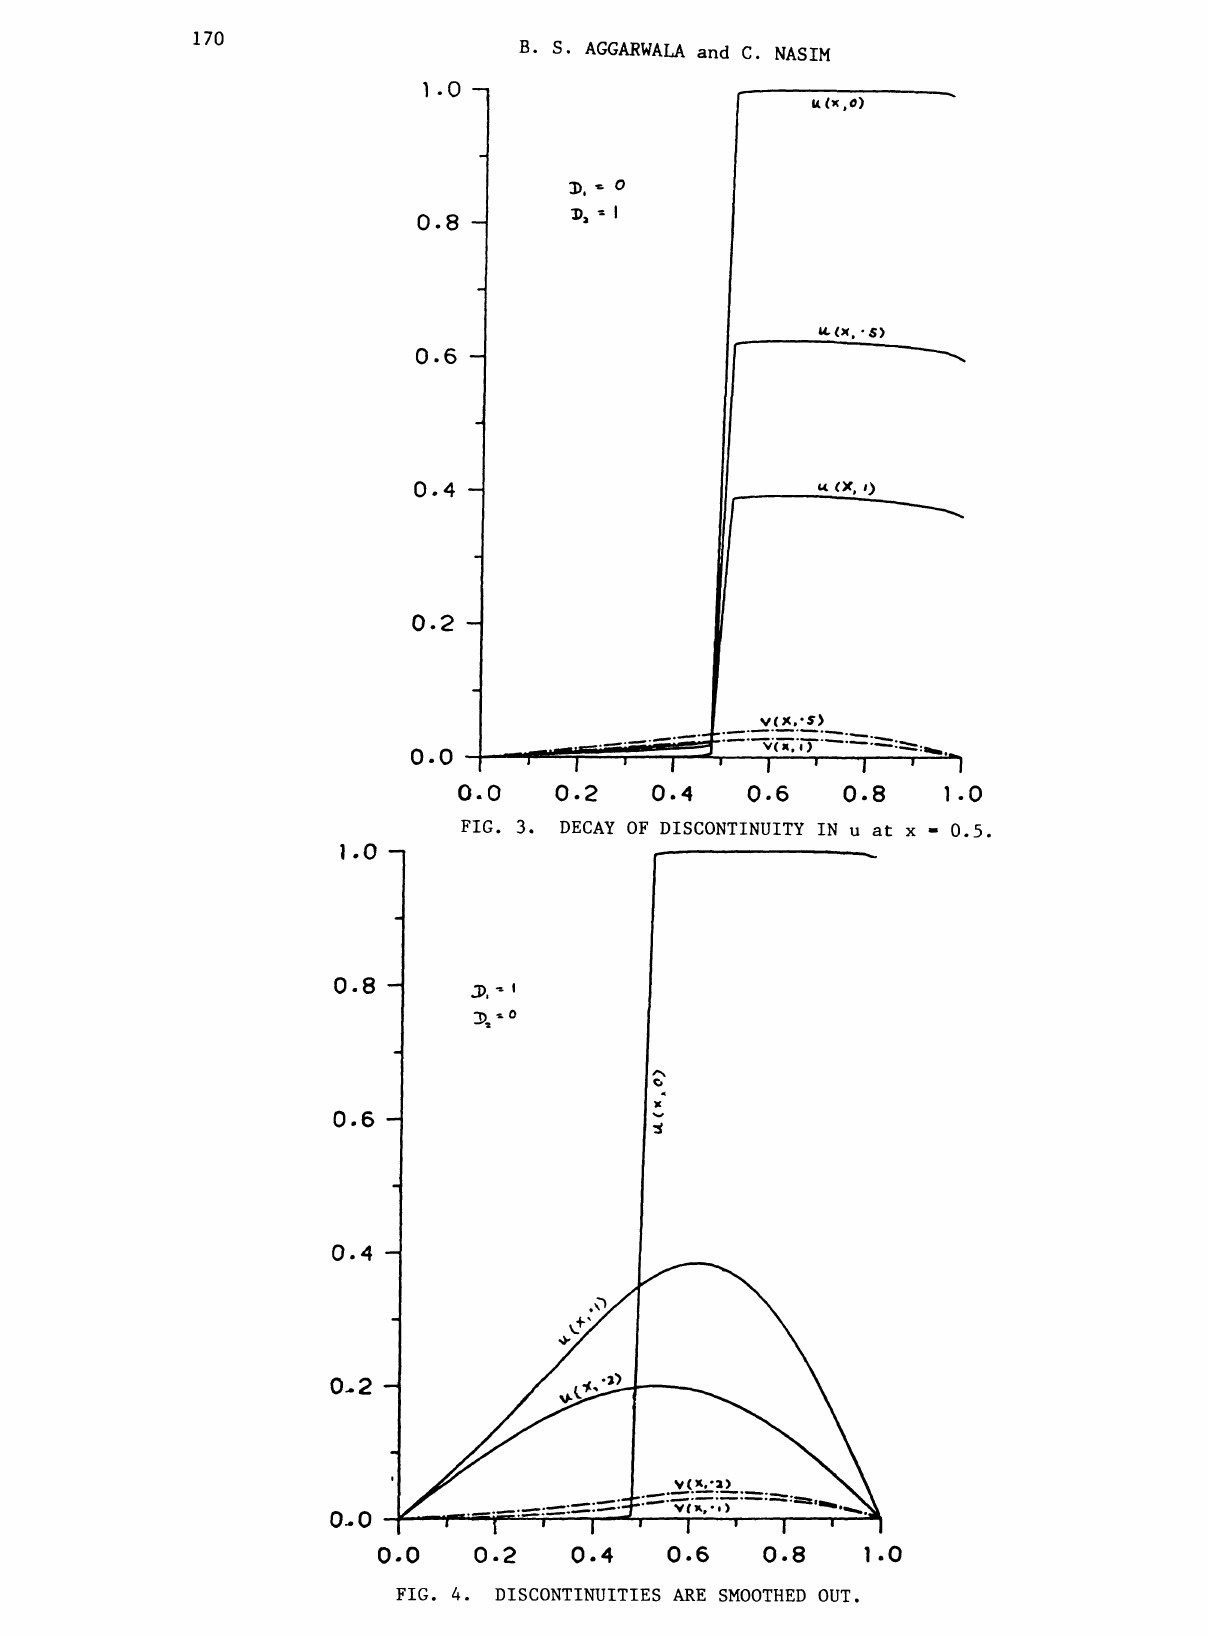
FIG. 4. DISCONTINUITIES ARE SMOOTHED